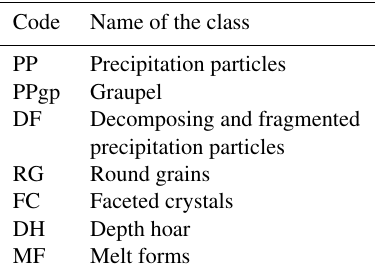
Table A1. Table of the standardized grain shape classes used in this study. See Fierz et al. (2009) for a detailed description of each